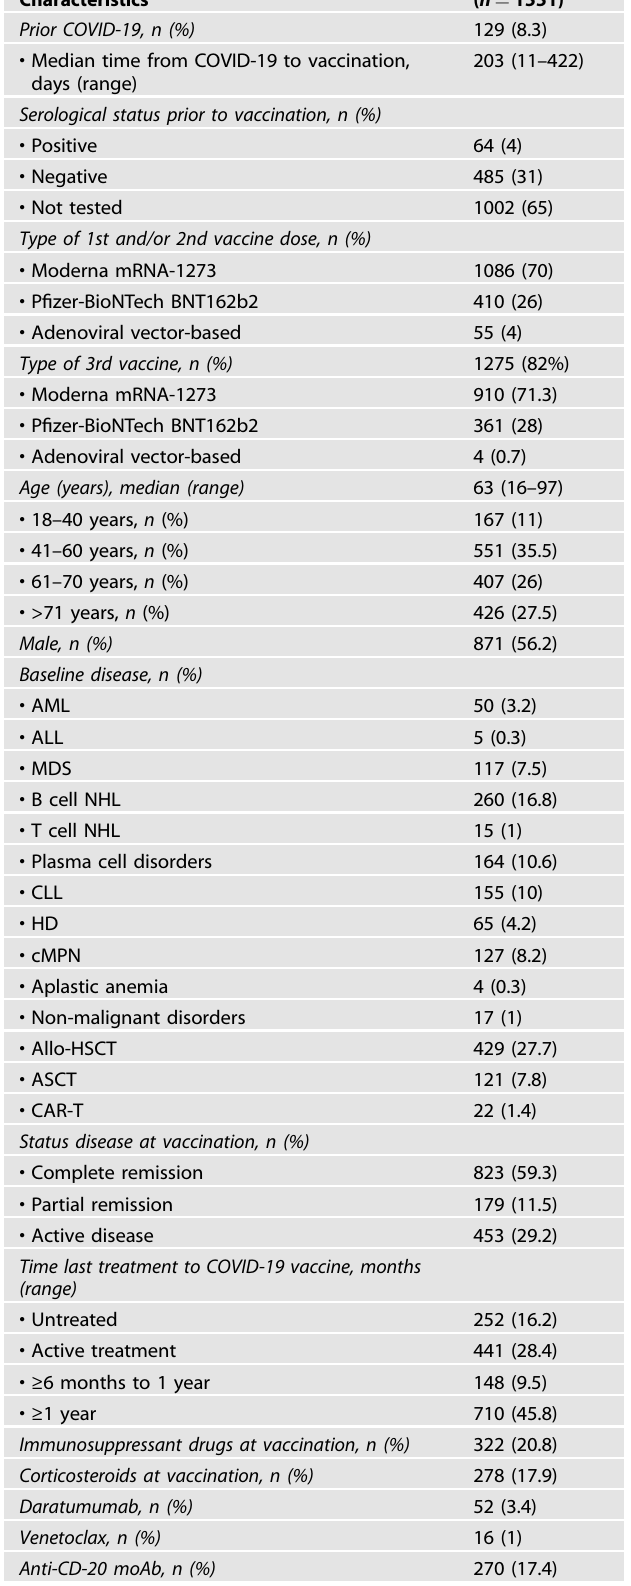
Table 1. Patient characteristics.